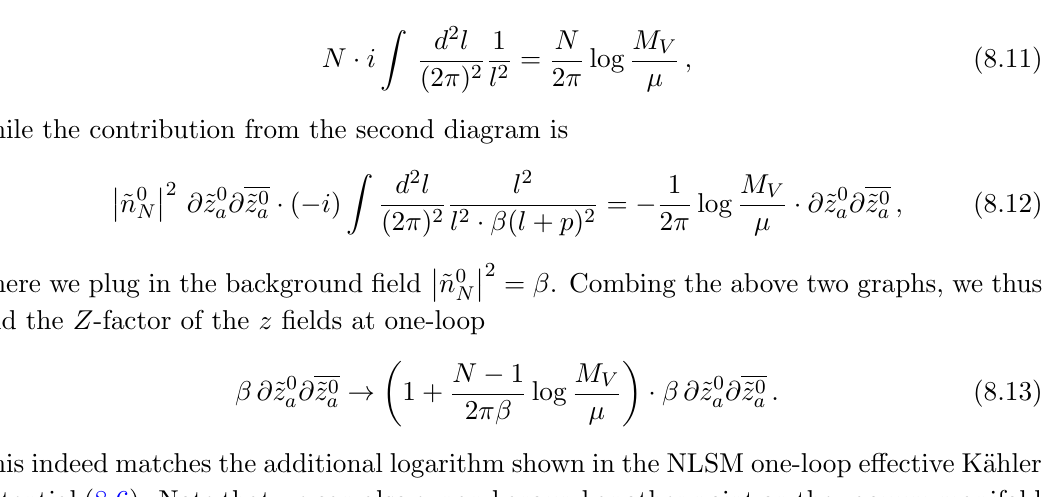
Figure 6. The solid lines are the background (cid:12)eld @ ~ z 0 and the curvy line is the quantum ~ z (cid:12)eld, ~ z q only for ~ n q as indicated in N